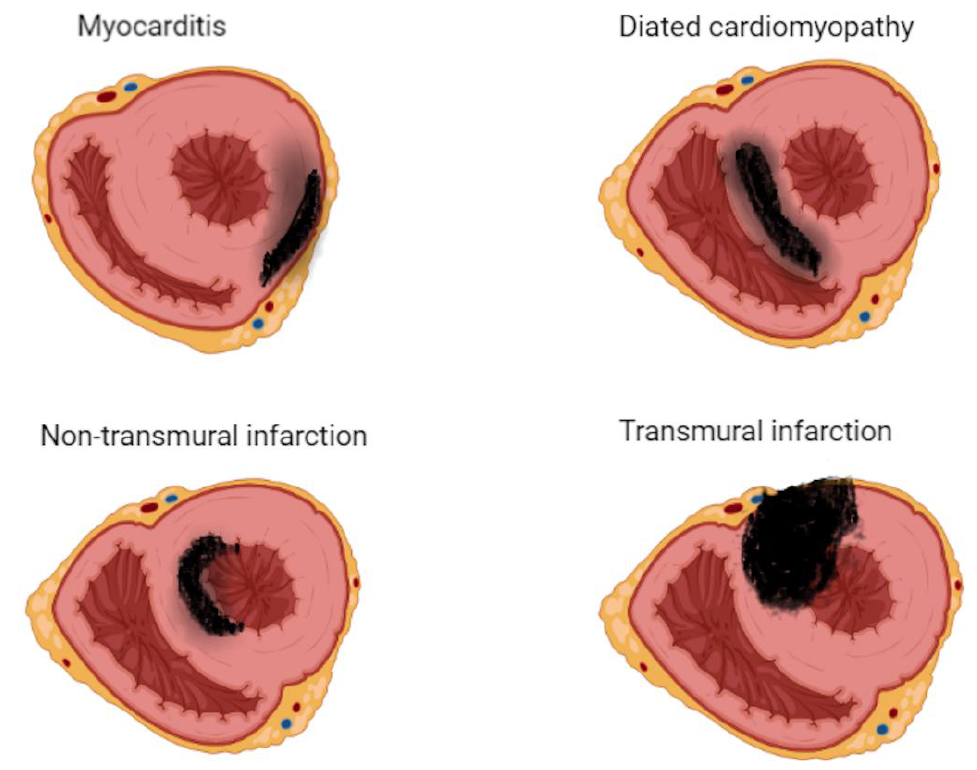
Figure 3. Late gadolinium enhancement (LGE) imaging allows the noninvasive visualization of areas affected by myocardial scar, conferring clinicians the unique ability to differentiate ischemic from nonischemic lesions based on typical LGE